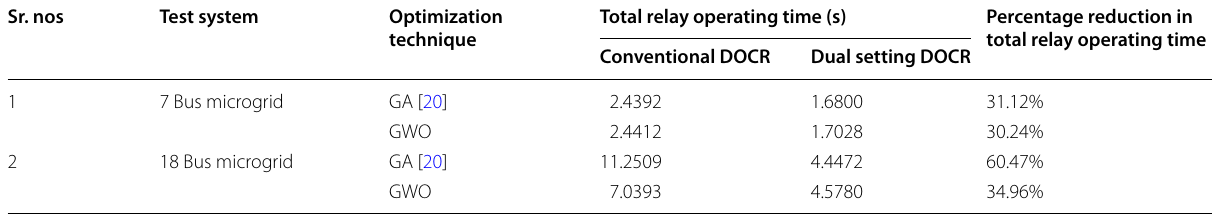
Table 11 Summary of total relay operating time using single and dual setting overcurrent relays in common operating mode Sr.